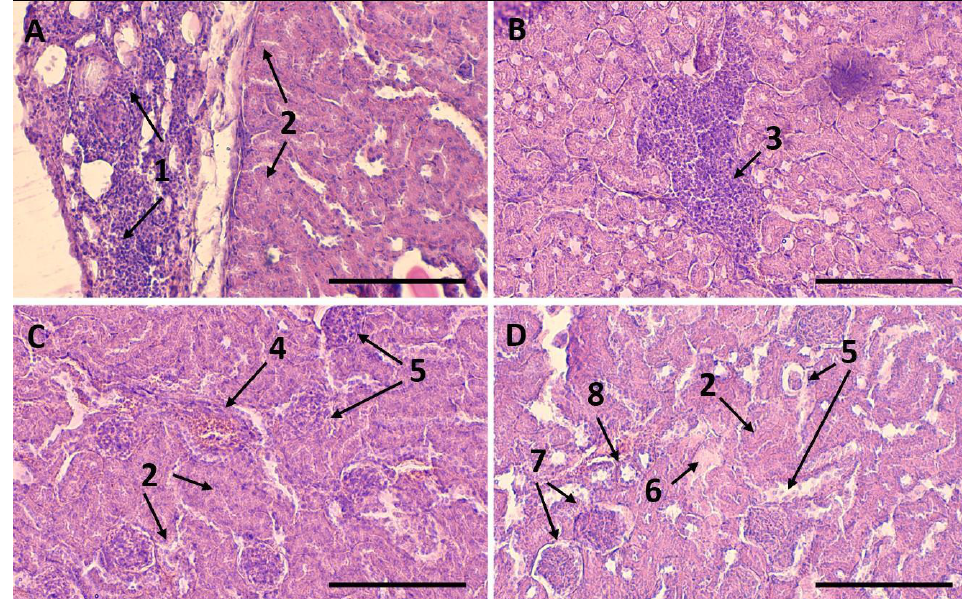
Figure A2. The histological image of the kidney 5 days after the microcapsules injection shows that the renal tissue has a normal structure. The thickness of the histological samples is 5 μm; dyes: hematoxylin and eosin. The scale bar is 200 µm.